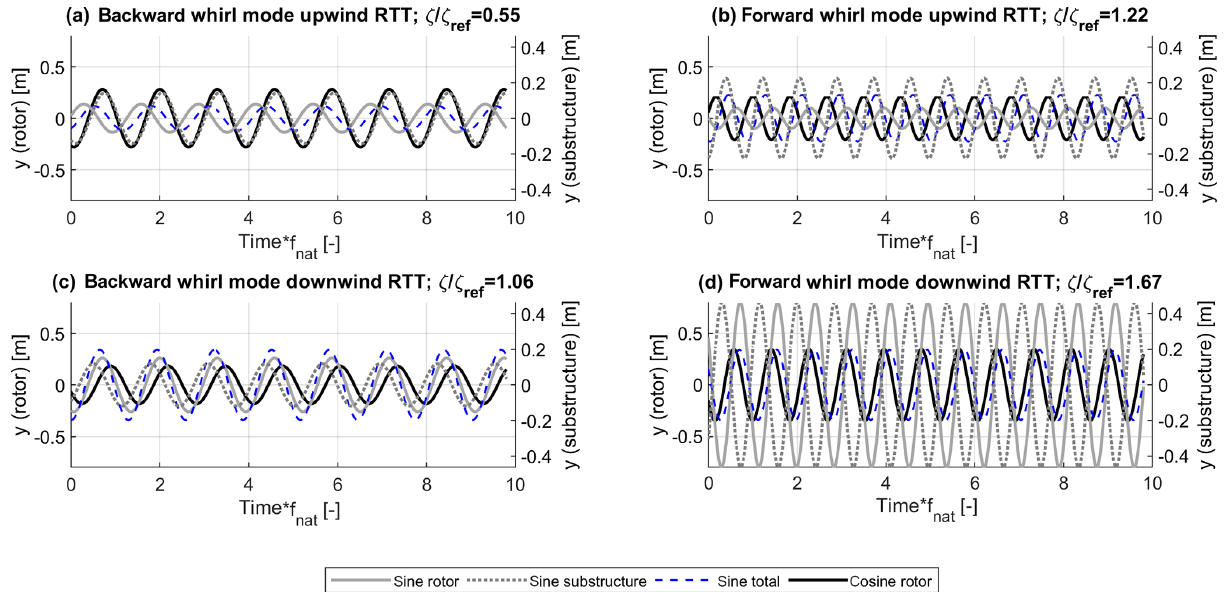
Figure A3. Modal out-of-plane displacements at 9ms − 1 and a tower torsional stiffness factor of 0.2 for the backward whirl mode and forward whirl mode of the upwind RTT and downwind RTT configurations. The time axis is normalized with the blade edgewise natural